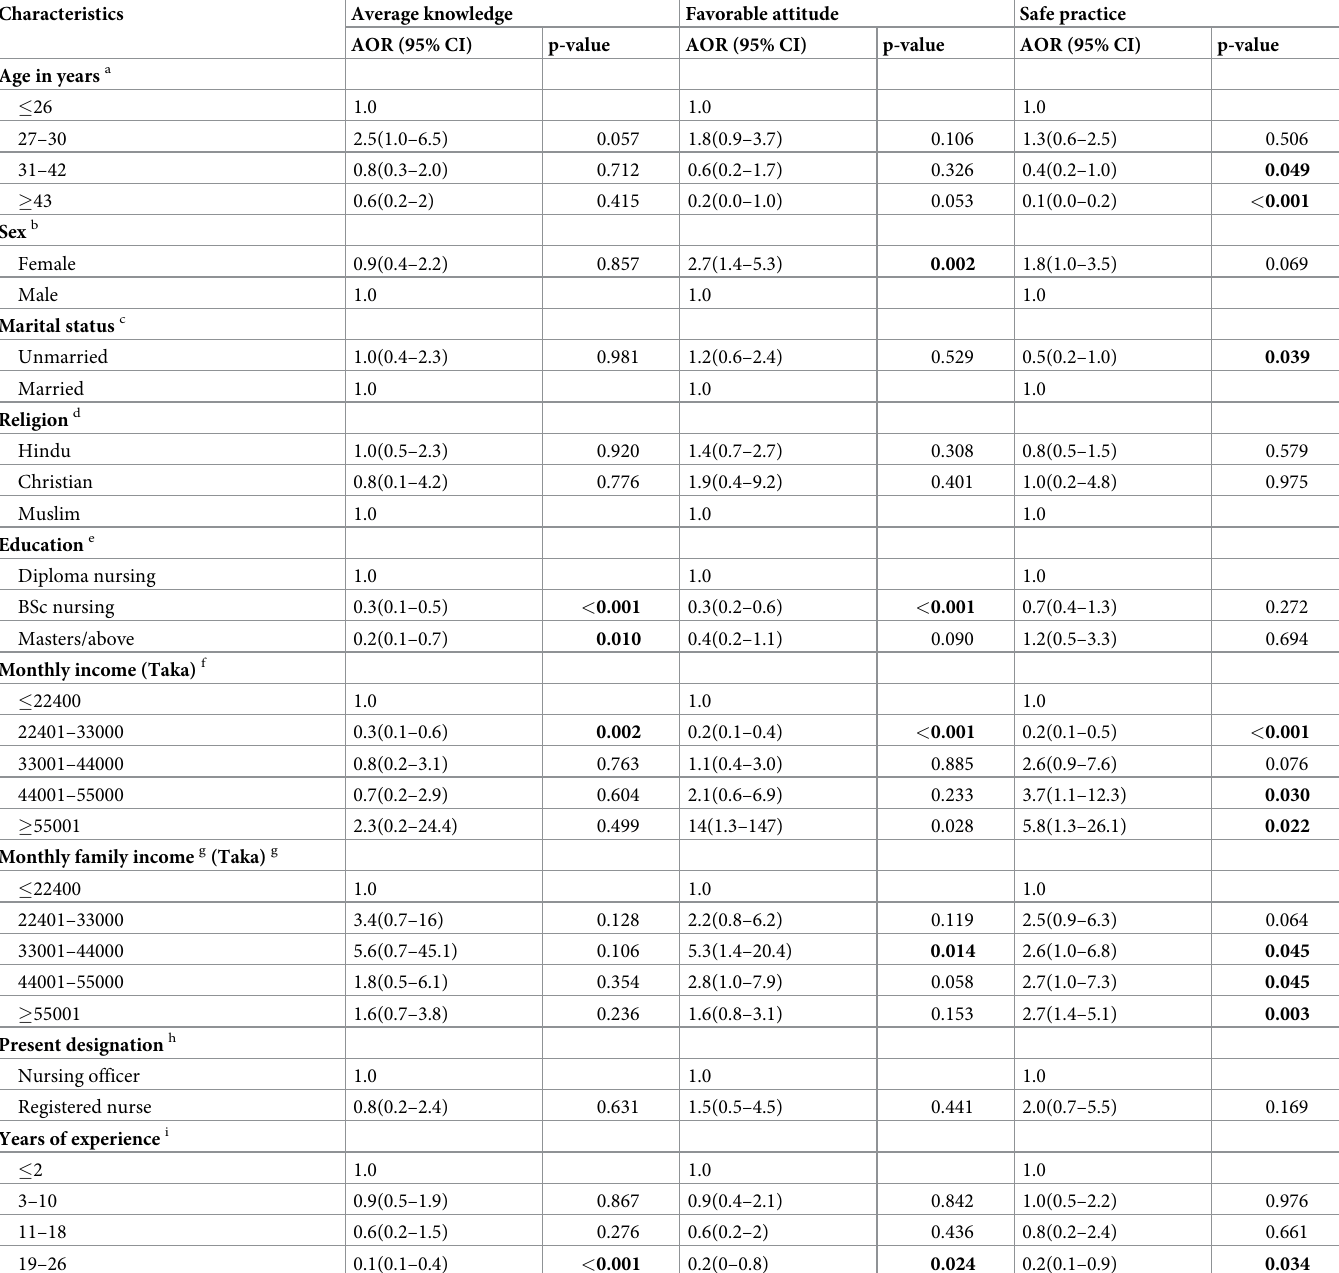
Table 6. Multivariable analysis of factors associated with levels of average knowledge, favourable attitude and safe practice toward infection prevention and control.